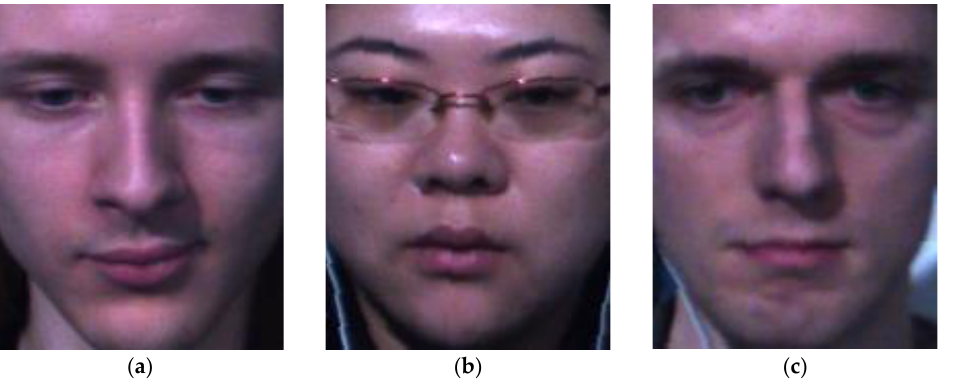
Figure 16. Incorrect recognition results on the SMIC dataset: ( a ) positive predicted as negative, ( b ) negative predicted as surprise, and ( c ) surprise predicted as negative.